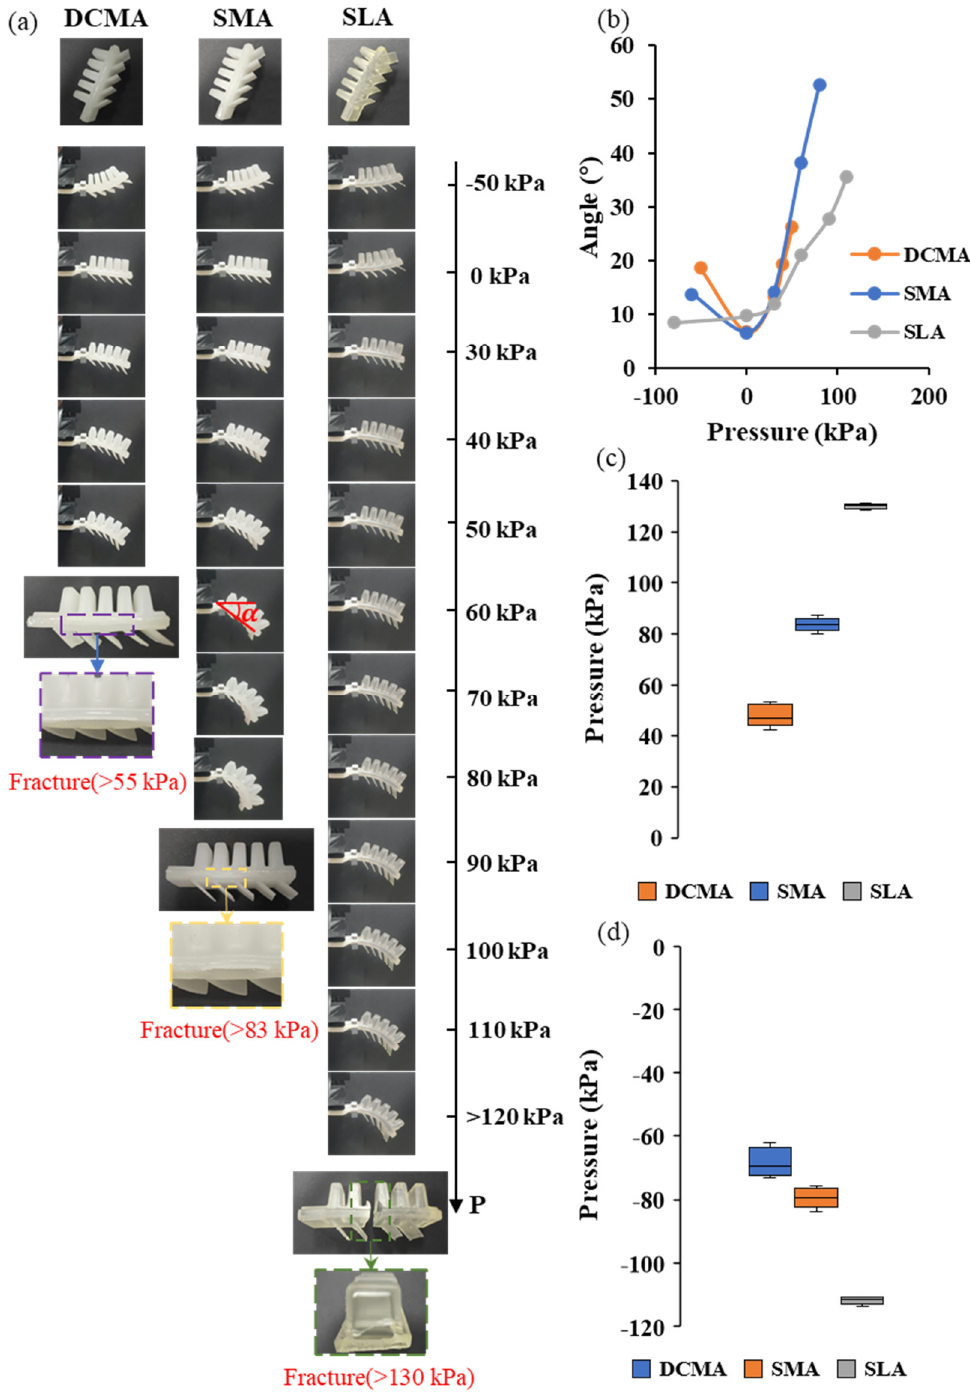
Figure 8. Respective performances of Bio-AU samples fabricated via three processes: ( a ) comparison of bending performance and rupture failure of Bio-AU samples; ( b ) bending performance of Bio-AU samples; ( c ) box diagram of positive pressure-bearing ranges of Bio-AU samples; and ( d ) box diagram of negative pressure-bearing ranges of Bio-AU samples.